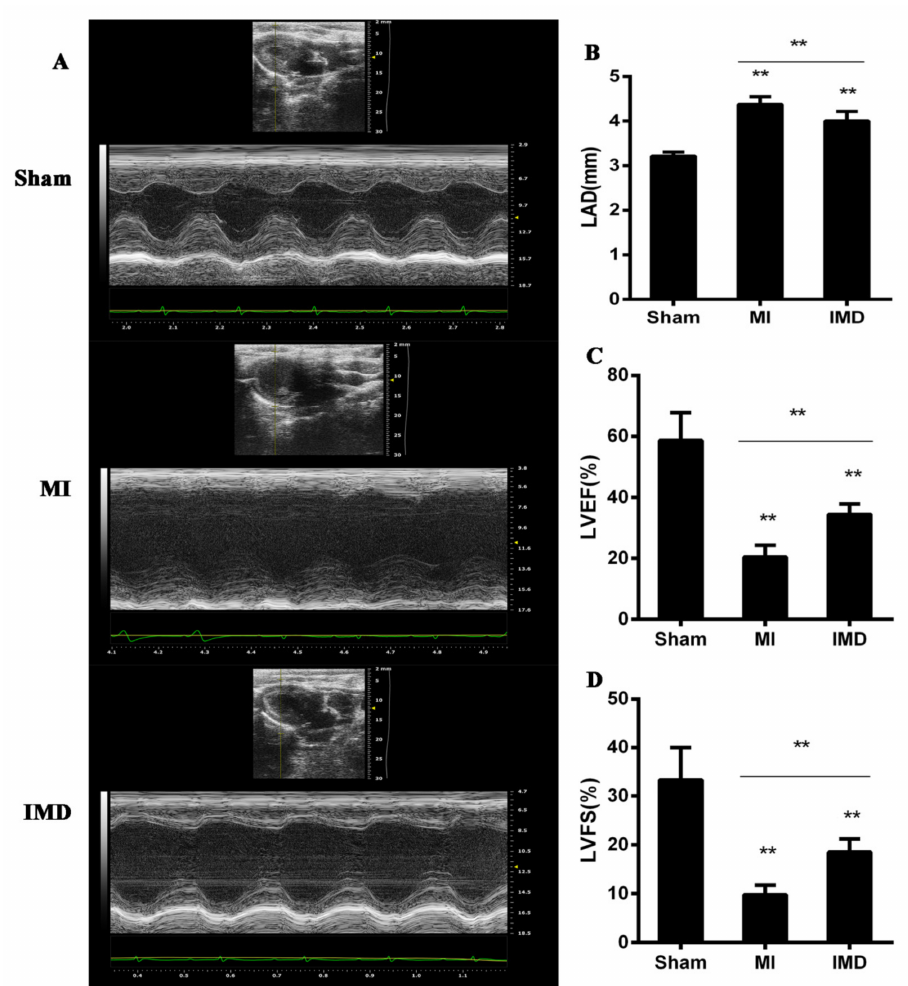
Figure 1. Effects of IMD1-53 treatment on cardiac contractile function and LAD after MI surgery. ( A ) Representative examples of M-mode echocardiogram of three groups. ( B ) Bar graphs indicate the LAD. IMD1-53 decreased LAD after MI. ( C ) Bar graphs indicate the LVEF. IMD1-53 improved LVEF after MI. ( D ) Bar graphs indicate the LVFS. IMD1-53 improved LVFE after MI. Data in bar graphs are means ± SD, n = 10. LVEF, left-ventricular ejection fraction; LVFS, left-ventricular fraction shortening; LAD, left-atrial diameter; MI, myocardial infarction; IMD1-53, intermedin 1-53. ** p <